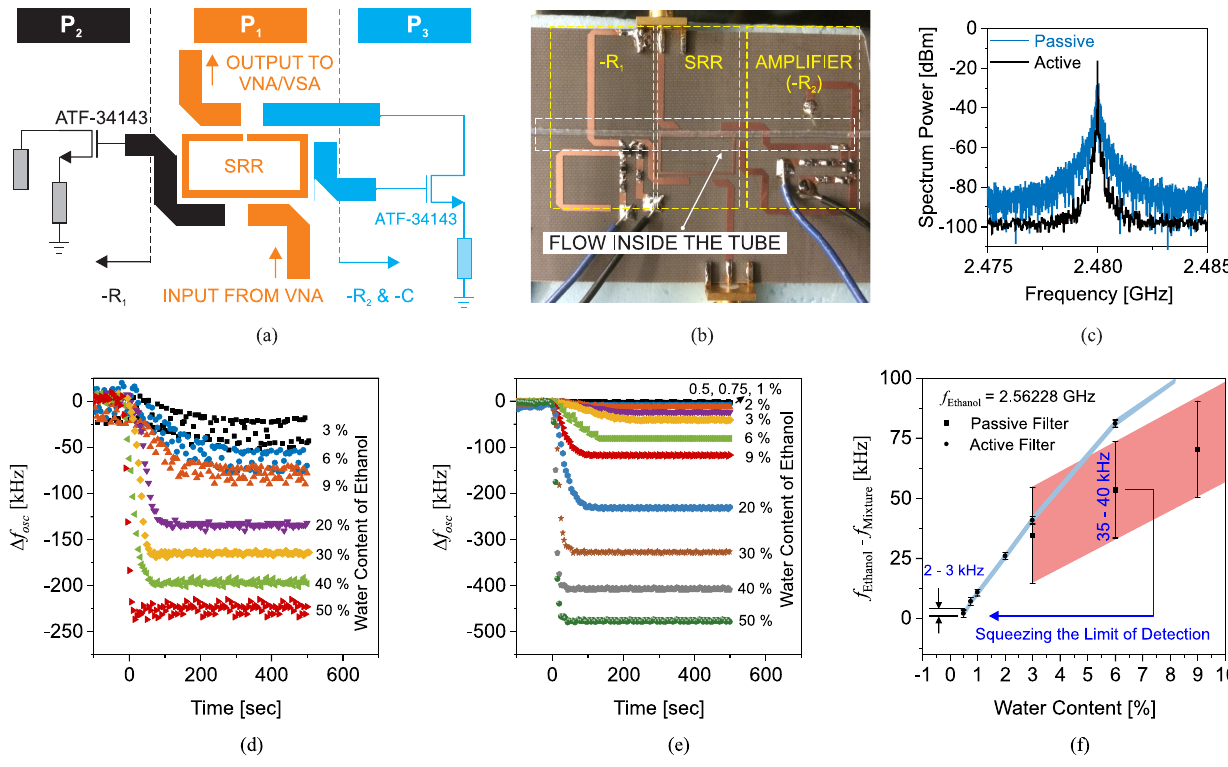
Figure 42. Active sensor with active tank: design, schematic and sensing results: ( a ) schematic of the oscillator with active tank; ( b ) fabricated oscillator with active tank; ( c ) spectrum power with oscillator tank in passive/active modes; ( d ) measured oscillation frequencies with concentrated water in ethanol with passive tank; ( e ) measured oscillation frequencies with concentrated water in ethanol using active tank; and ( f ) comparing the oscillation frequency stability in both a passive and active tank for a given MUT. Reprinted with permission from Ref.